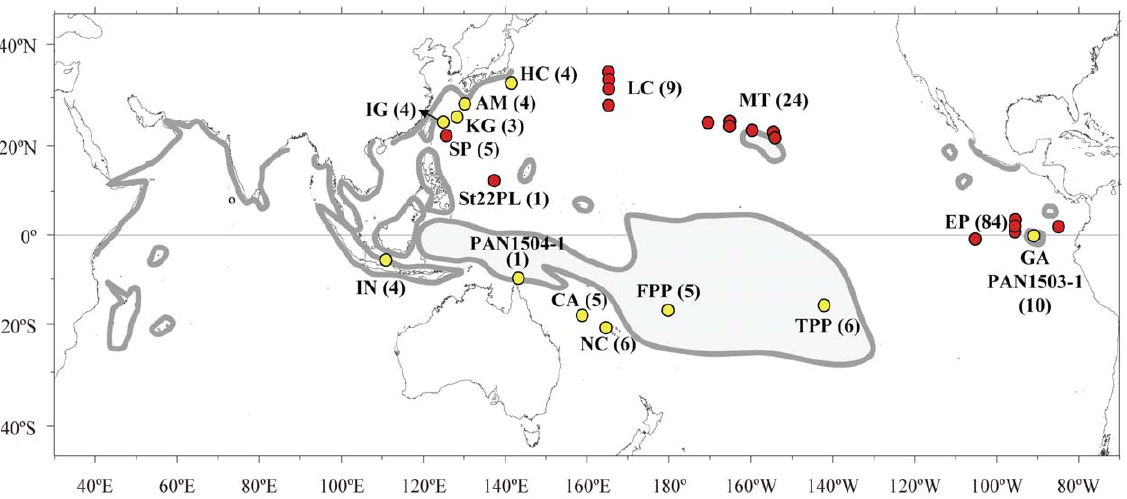
Figure 1. Collecting locations for the lobster samples used in this study are shown by yellow (adult) and red (larva) circles. Distribution of the pronghorn spiny lobster ( Panulirus penicillatus ) after Holthuis [2] is indicated by shaded line.